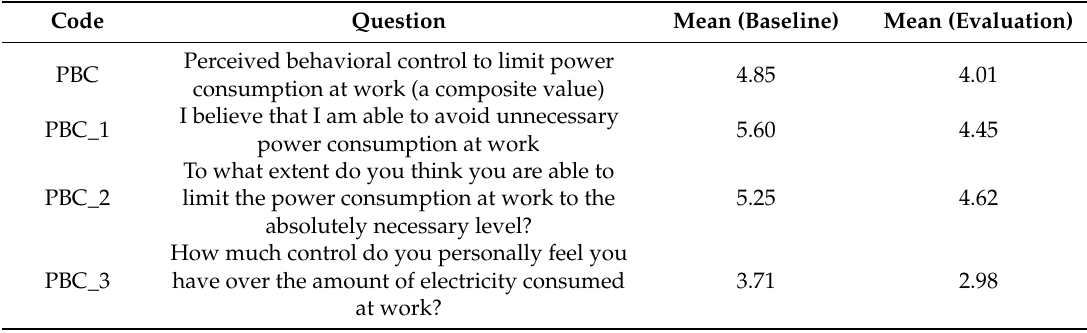
Table 11. Mean scores for factors related to perceived behavioral control (PBC) (not at all able to do it (1) to able to do it to a great extent (7) / very little control (1) to complete control (7)).